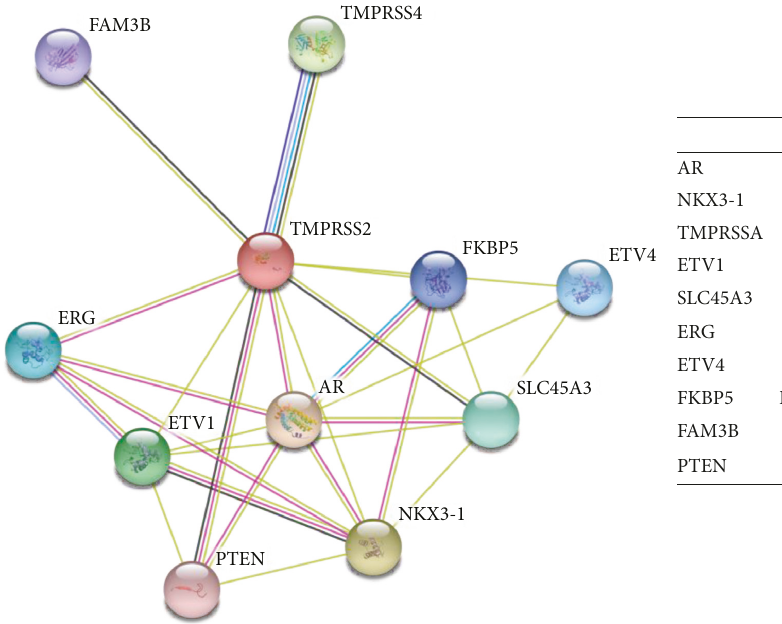
Figure 8: Protein-protein interaction map of SARS-CoV-2-SG by